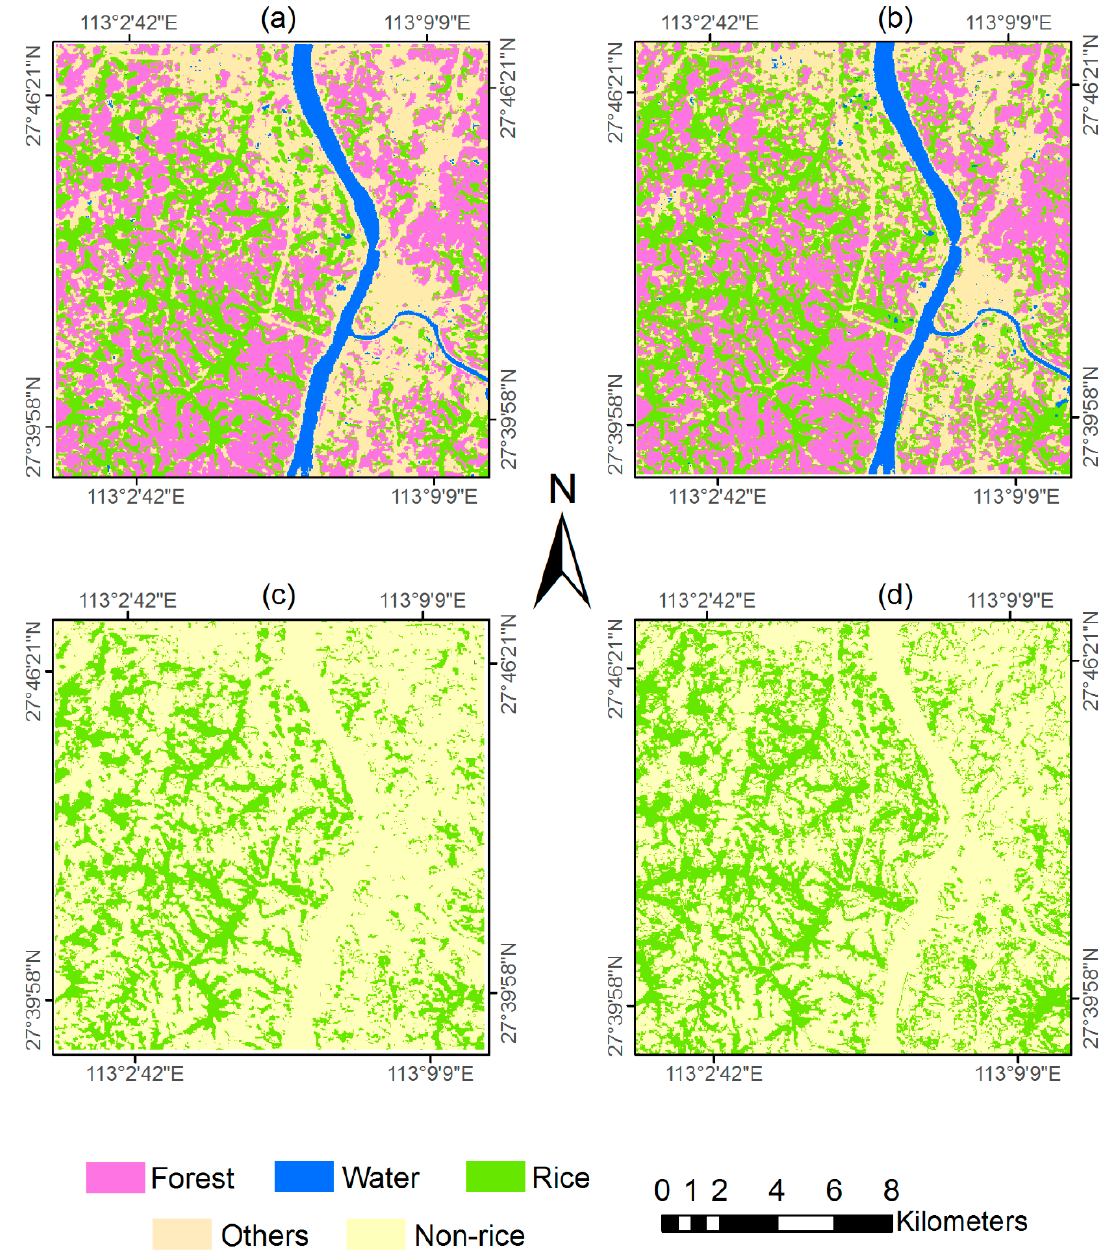
Figure 9. Classification results based on SVM and CNN. ( a , b ) gave the area of four land covers based on SVM and CNN, separately; ( c , d ) displayed the independent spatial distribution of rice by SVM and CNN,